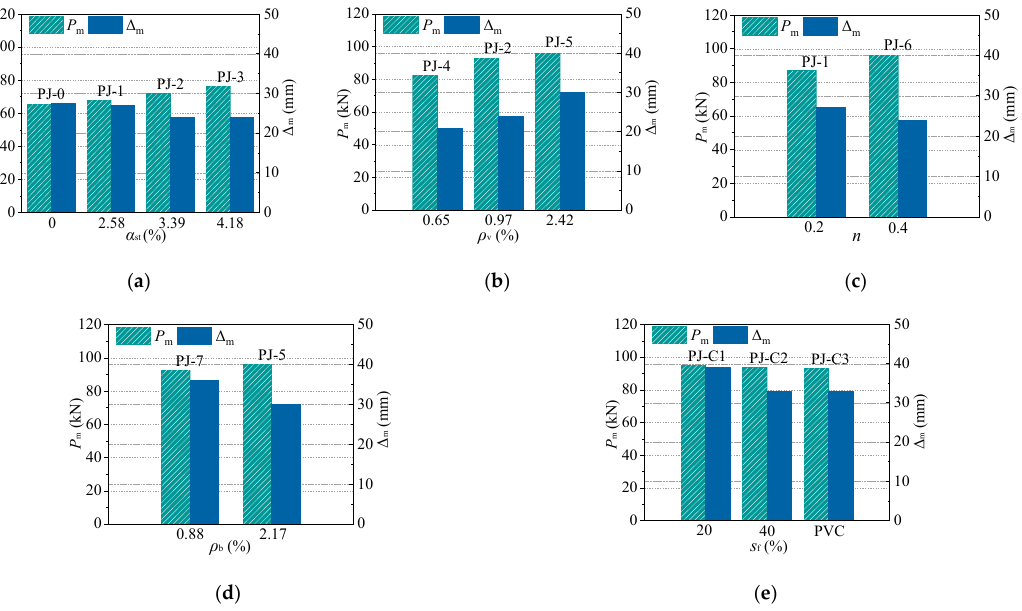
Figure 7. Effects of design parameters on the peak bearing capacity and deformation. ( a ) Steel ratio of STC. ( b ) Stirrup ratio of the joint. ( c ) Axial compression ratio. ( d ) Reinforcement ratio of the frame beam. ( e ) CFRP strips spacing.